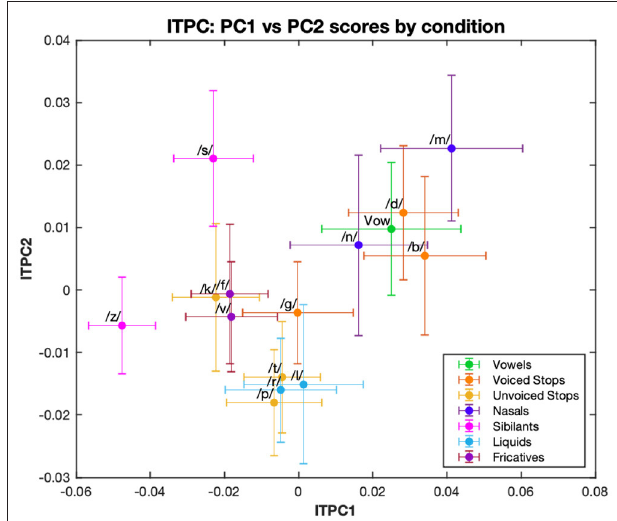
FIGURE 3 | First and second principal components of ITPC. The ITPC values at 4, 8, 12, and 16Hz are multiplied by their respective PCA loadings for the first two principal components, and then plotted for each condition. Different color graphs represent the phonemic category: vowel-only or for syllable-initial consonants, their manner of articulation.